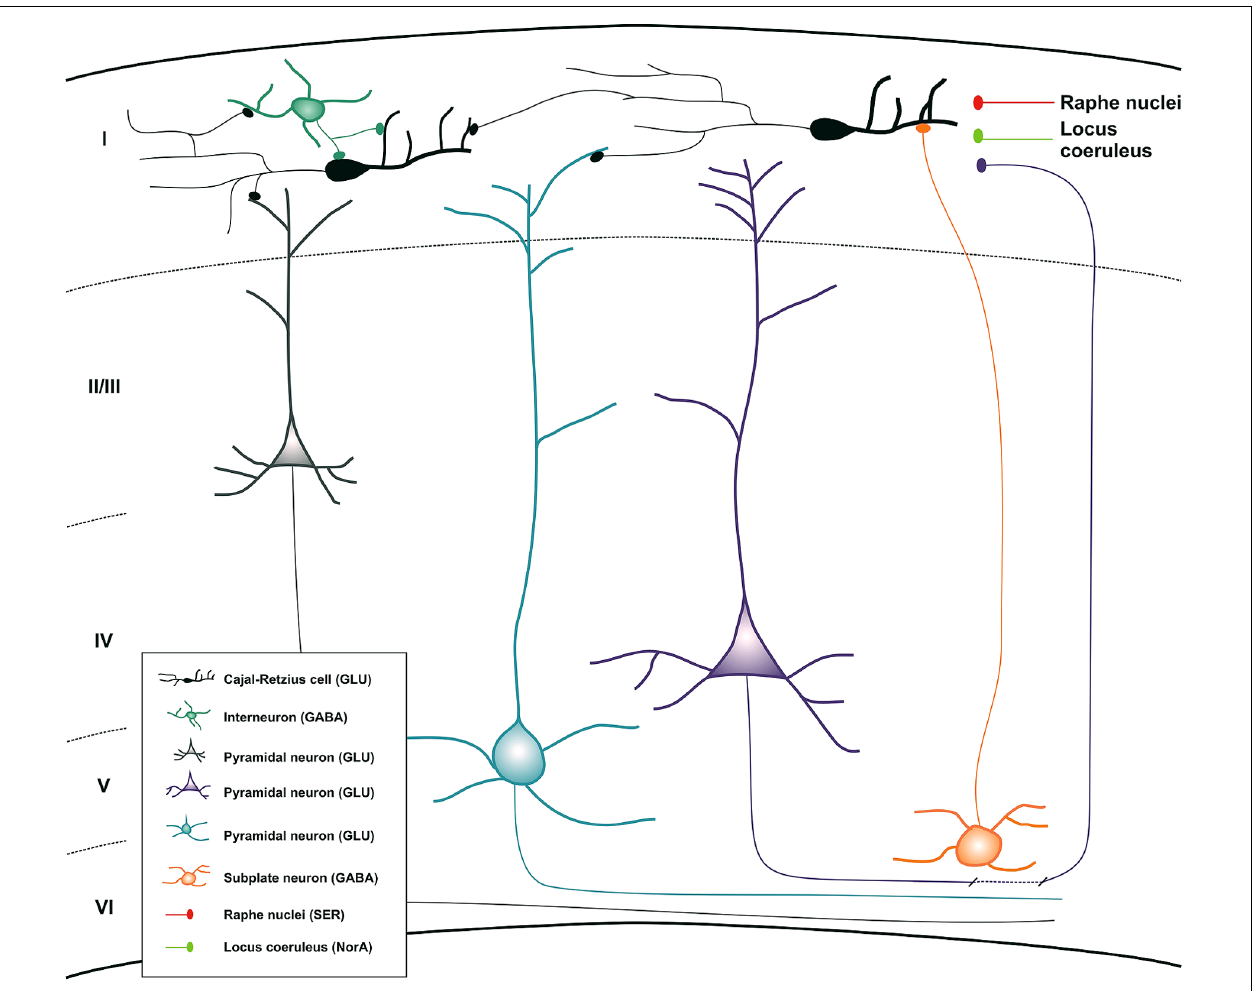
FIGURE 3 | Schematic drawing summarizing all the inputs and outputs connections of CR cells during neocortical development. Inset map shows the distinct cell populations involved in the process with their principal neurotransmitters. Abbreviations: GLU, glutamate; GABA, gamma-aminobutyric acid; NorA, noradrenalin; SER,